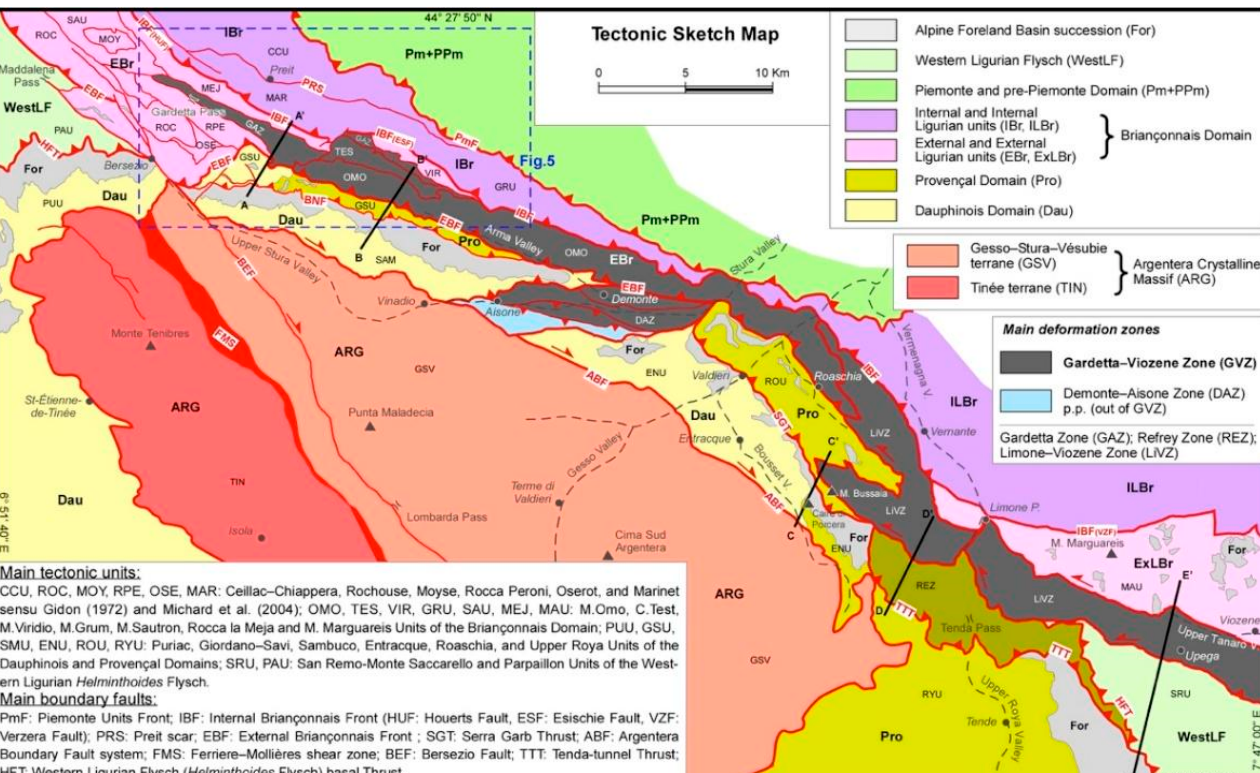
Figure 3. Geological sketch map of the southern termination of the Western Alps adapted from [23]. The Gardetta-Viozene Zone is highlighted (in grey). The main tectonic units are represented referring to their different paleogeographic pertinence (different colors) and geometrical position with respect to the main tectonic boundaries and deformation zones. The location of geological cross-sections of Figure 4 (sections A-A’, B-B’, C-C’, D-D’, E-E’) is reported. The Internal Briançonnais Front (IBF) here corresponds to the external boundary of the green-schist to eclogite facies metamorphic axial belt of the Alps ( sensu [69]) and can be thus considered as the surface expression of the Penninic Front.